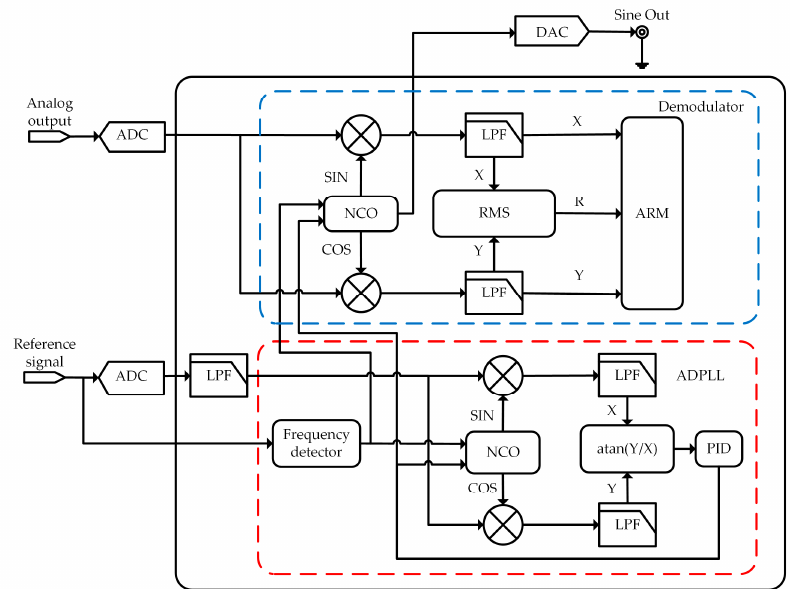
Figure 5. Structure of the reconfigurable hardware including a demodulator and an all-digital phase lock loop (ADPLL). (NCO is numerically controlled oscillator, RMS is root-mean-square, ARM is advanced reduced instruction set computer machine, PID is proportion-integral-di ff erential, DAC is digital-to-noise converter.)